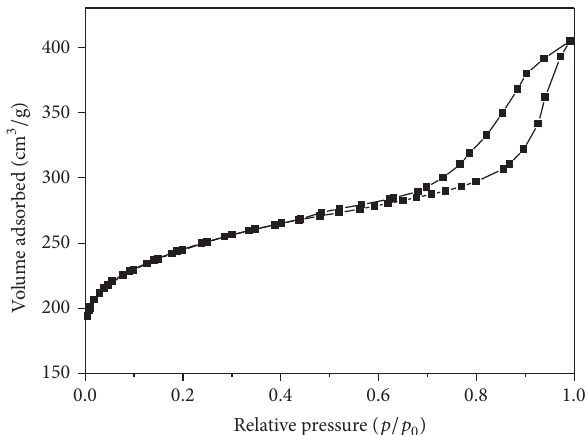
Figure 2: N 2 adsorption-desorption isotherms of the composite